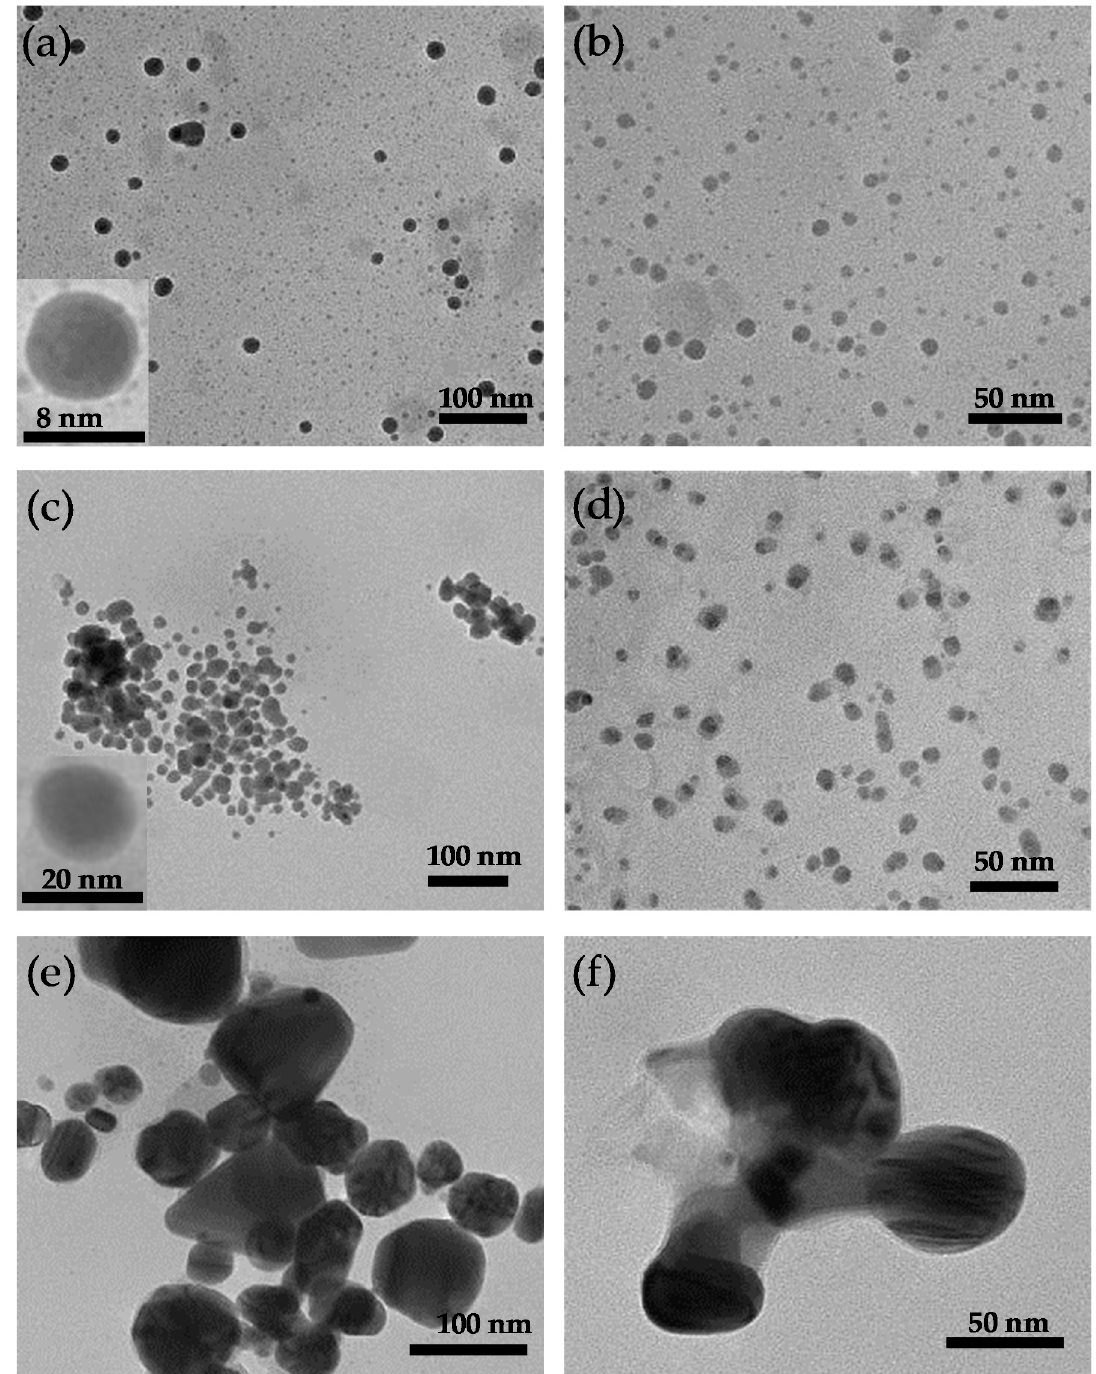
Figure 7. TEM images AgNPs produced by: ( a ) WLC-1.250 mM; ( b ) WLC-0.625 mM; ( c ) EPS-S-1.250 mM; ( d ) EPS-S-0.625 mM; ( e ) LCFM-1.250 mM; and ( f ) LCFM-0.625 mM.